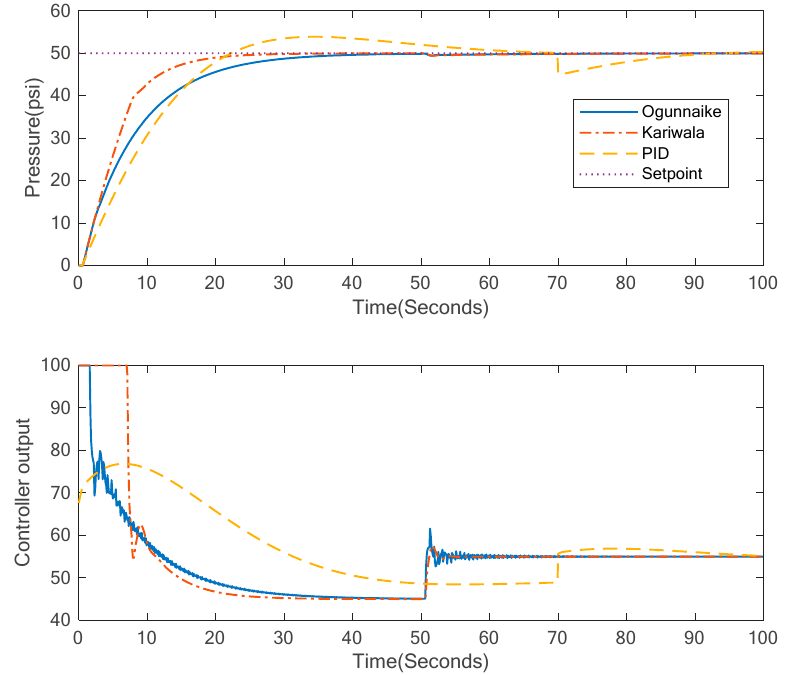
Figure 25. Example 2: Regulatory response for the pressure control station with tuning rules and PID.